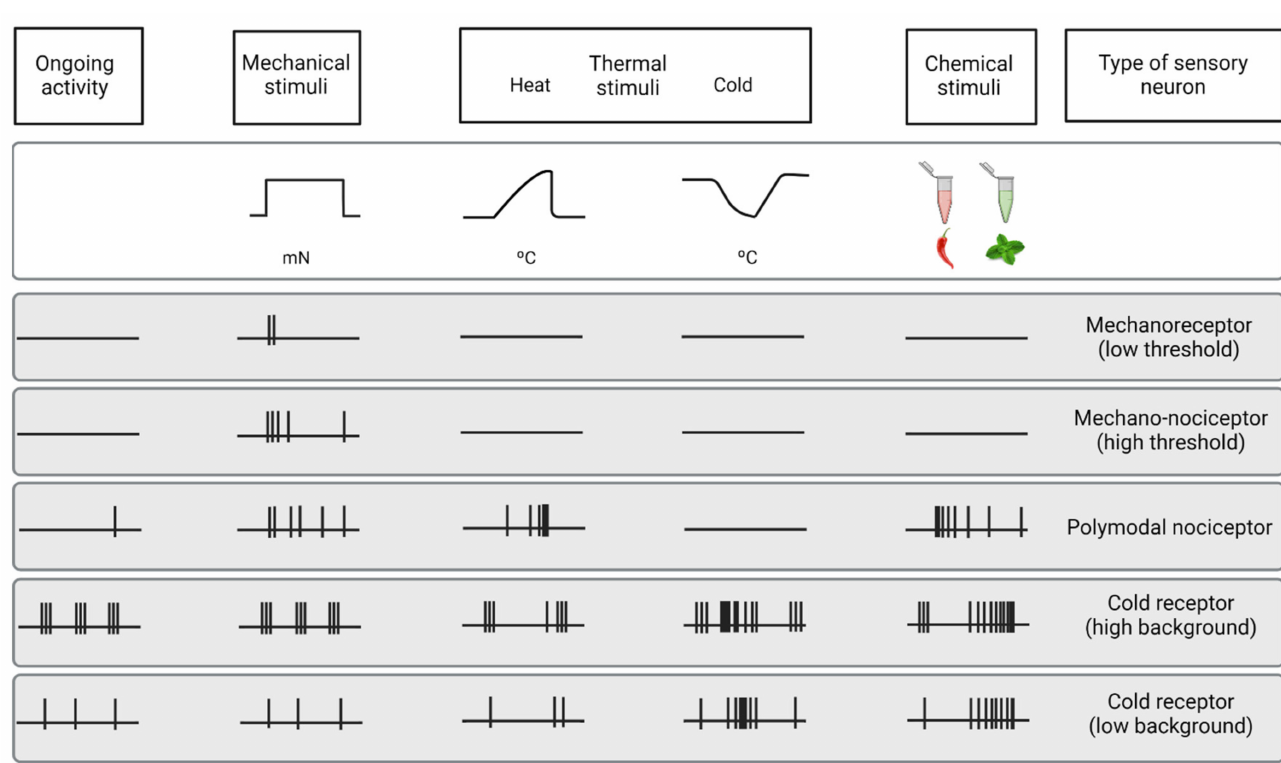
Figure 3. Functional types of sensory neurons innervating the cornea. Schematic representation of the spontaneous and stimulus-evoked nerve impulse activity of the different functional types of sensory nerves innervating the cornea. Based on the characteristics of the impulse discharge in absence of intended stimulation (ongoing activity) and response to different types of stimuli (upper part of the figure), the peripheral terminals of primary sensory neurons innervating the cornea are classified into five different functional types of sensory